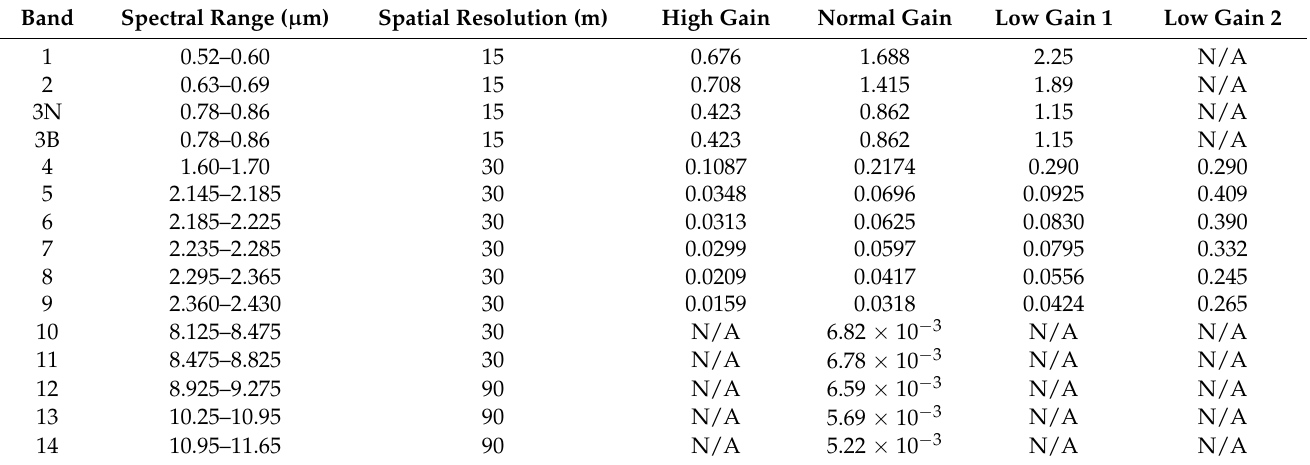
Table 1. Spectral and spatial features of Advanced Spaceborne Thermal Emission and Reflection Radiometer (ASTER) bands and relative unit conversion coefficient (UCC) (W/m 2 sr µ m) values, depending upon gain mode (normal, high-gain,